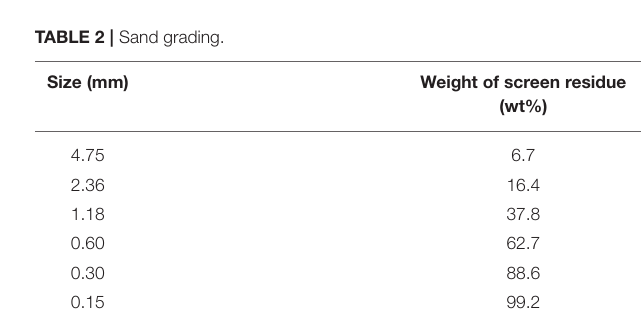
FIGURE 1 | Particle size distribution of MK.